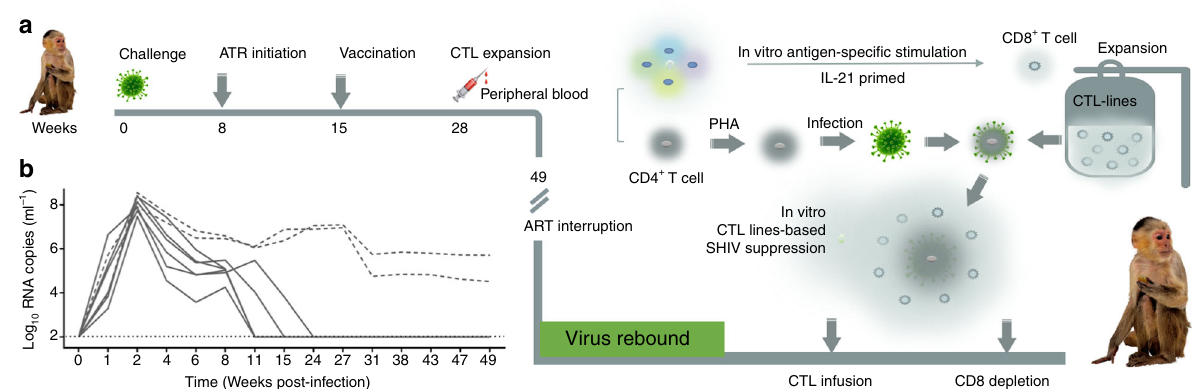
Fig. 1 Experiment design and major procedures intervention. a Experiment design. b Viral RNA in SHIV-SF162P3 infected macaques before ART interruption (limit of detection, 2 Log RNA copies per ml). Dotted lines indicate the macaques without viral control during